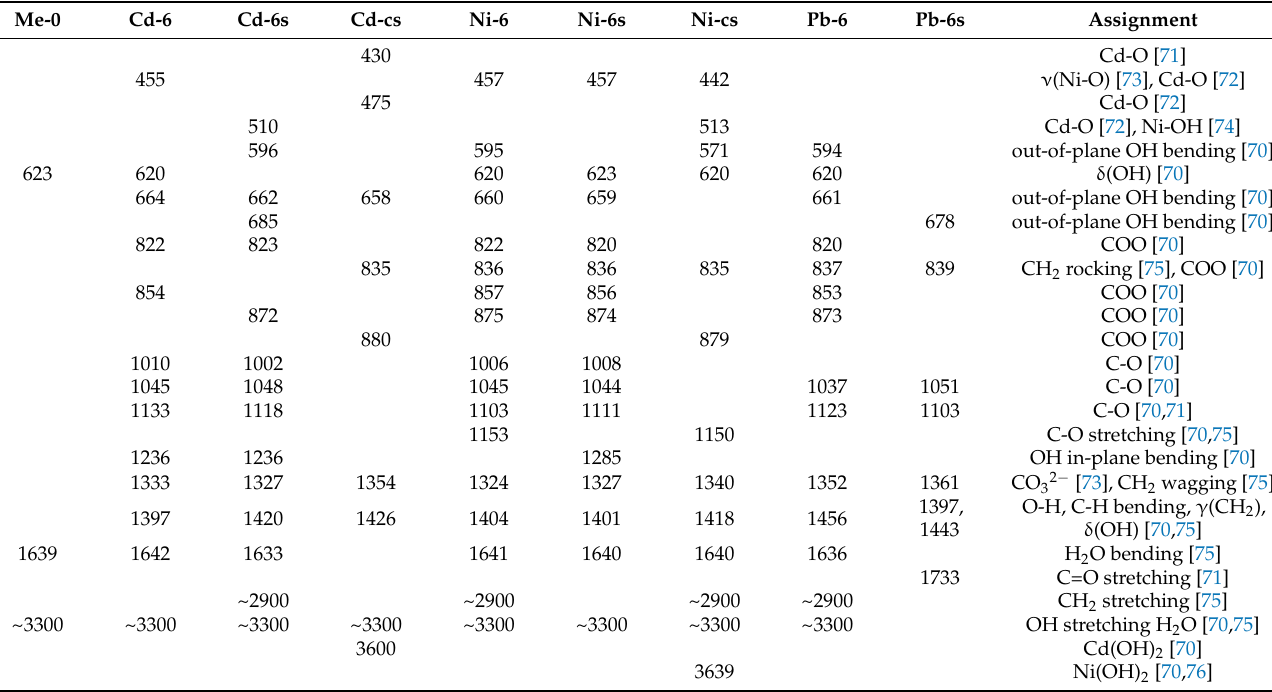
Table 9. Assignment of peaks in FTIR spectra (Me stands for Cd, Ni,